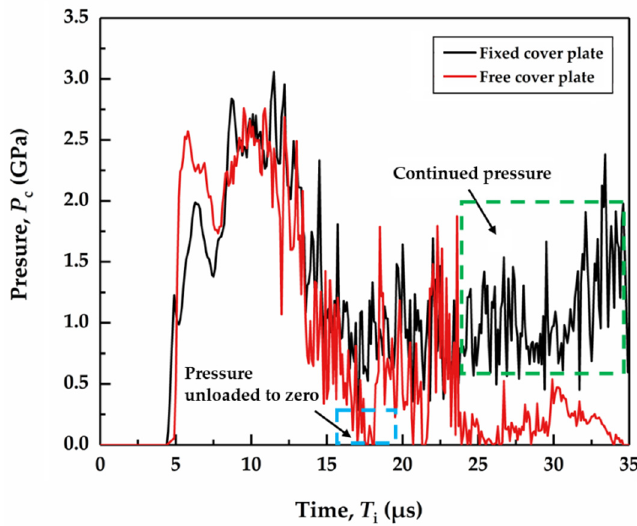
Figure 6. Time history of pressure at the gauge point on the SiC target surface with the fixed and free cover plate. The cover plate thickness is 4 mm and the impact velocity is 1250 m/s.